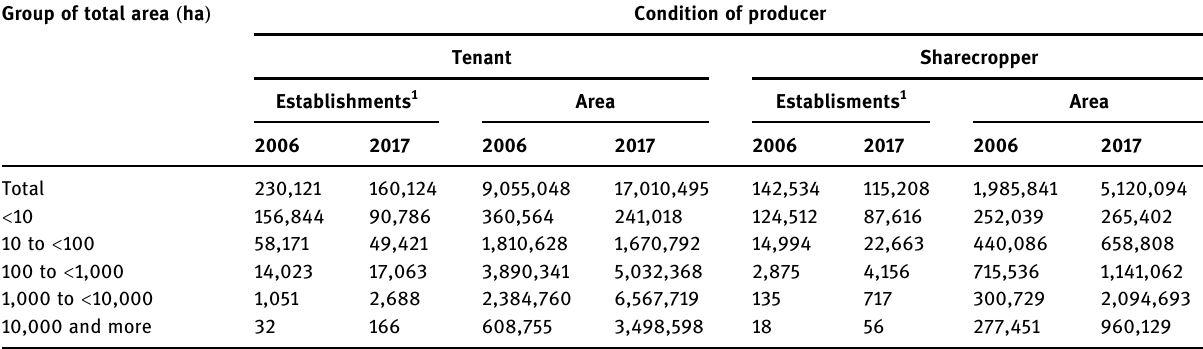
Table 3: Number of establishments and area, according to the producer ’ s pro fi le per group of total area – Brazil ( 2006 and 2017 ) Group of total area ( ha